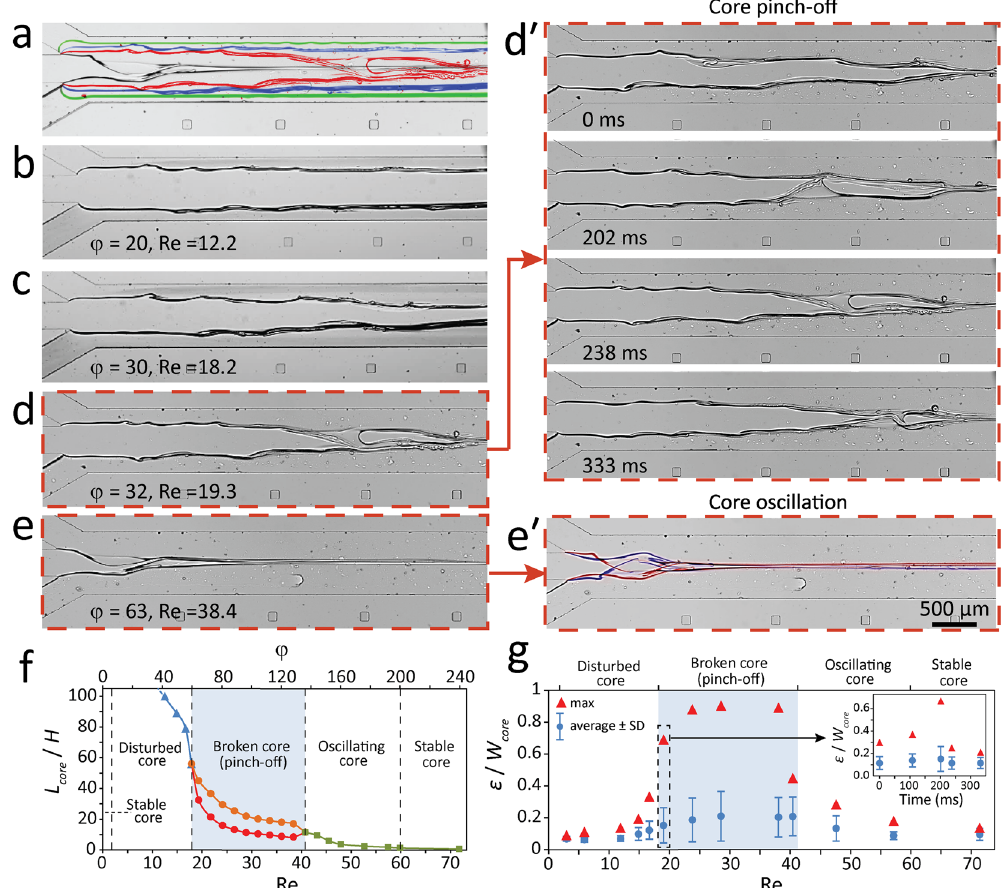
Figure 5. Formation of ‘broken core’ (pinched-off) and ‘oscillating core’ structures obtained by applying glycerol at 12.5 µ l/min while applying water at varying flow rates of 25 to 3000 µ l/min: ( a ) Stacked images obtained at various sheath flow rates, ( b – e ) Individual images obtained at various sheath flows corresponding to Reynolds numbers of 12.2, 18.2, 19.3, and 38.4, showing the transition from ‘disturbed core’ to ‘broken core’ and ‘oscillating core’ regimes, ( d ʹ ) Four stages of ‘broken core’ regime, involving core halting, expansion of waves, pinch-off and recovery, ( e ʹ ) Stacked images of ‘oscillating core’, ( f ) Variations of core length ratio against Reynolds number and sheath/core flow ratio, and ( g ) Variations of core roughness ratio at the interface of core- sheath flows against Reynolds